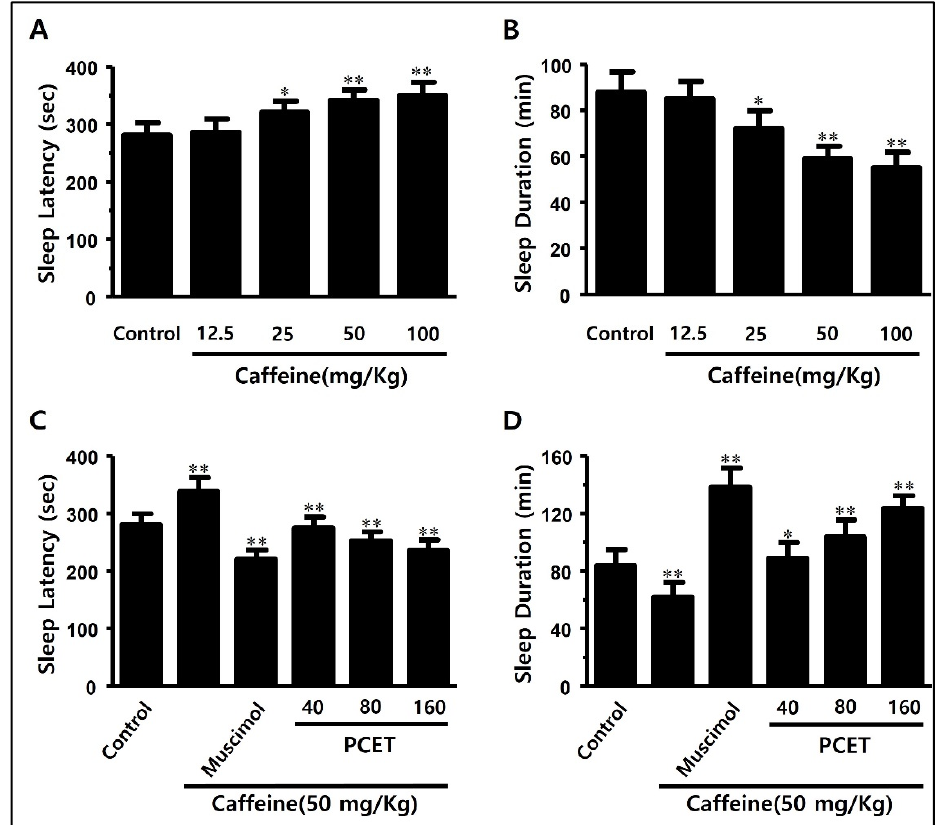
Figure 7. Effects of PCET on caffeine-induced sleep disturbance in mice. ( A , B ) Optimal caffeine concentration for inducing arousal-stimulating sleep disorders: ( A ) the effect of caffeine dosage on sleep latency and ( B ) total sleep time in pentobarbital-induced sleep tests. Caffeine (12.5, 25, 50, 100 mg/kg) was administered by oral gavage 45 min prior to the intraperitoneal pentobarbital injection (42 mg/kg). ( C , D ) Sleep improvement effect of PCET in caffeine-induced sleep disorders. Effect of PCET dosage on ( C ) changes in sleep latency and ( D ) total sleep time due to caffeine-induced awakening in pentobarbital-induced sleep tests. PCET was administered by oral gavage at concentrations of 40, 80, 160 mg/kg 45 min prior to the intraperitoneal pentobarbital injection (42 mg/kg), and caffeine (50 mg/kg) was also administered by oral gavage before the administration of PCET. Muscimol (0.2 mg/kg), the GABA receptor agonist, was injected intraperitoneally as a control. The data are shown as mean ± standard deviation. Each group consists of 10 mice. Statistical significance was evaluated based on the p -value, and significant differences from the negative control are marked by * p < 0.01 and ** p < 0.001.